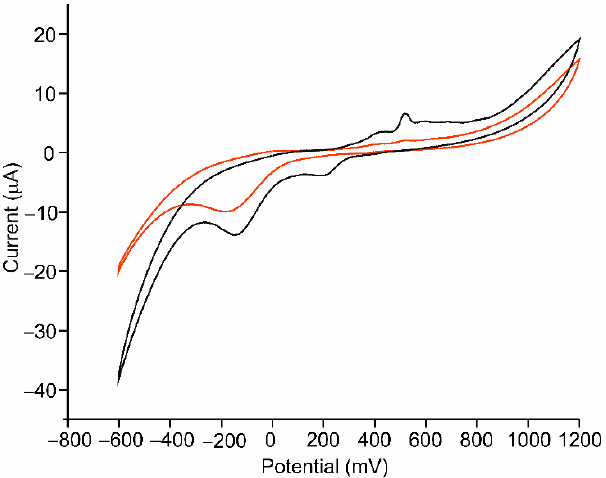
Figure 5. Voltammetric response in catechol 10 − 4 mol·L − 1 in 0.01 mol·L − 1 phosphate-buffered saline (PBS), pH 7.0 of a bare ITO (red) and ITO-AgNWs (black). (PBS), pH 7.0 of a bare ITO (red) and ITO-AgNWs